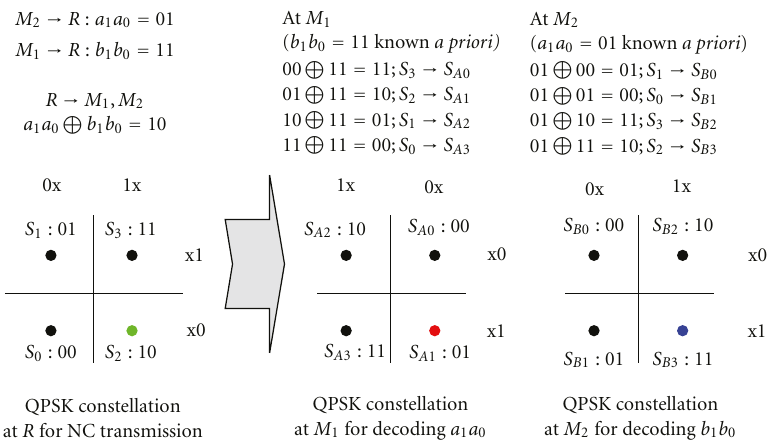
Figure 2: Reinterpretation of network-coding by